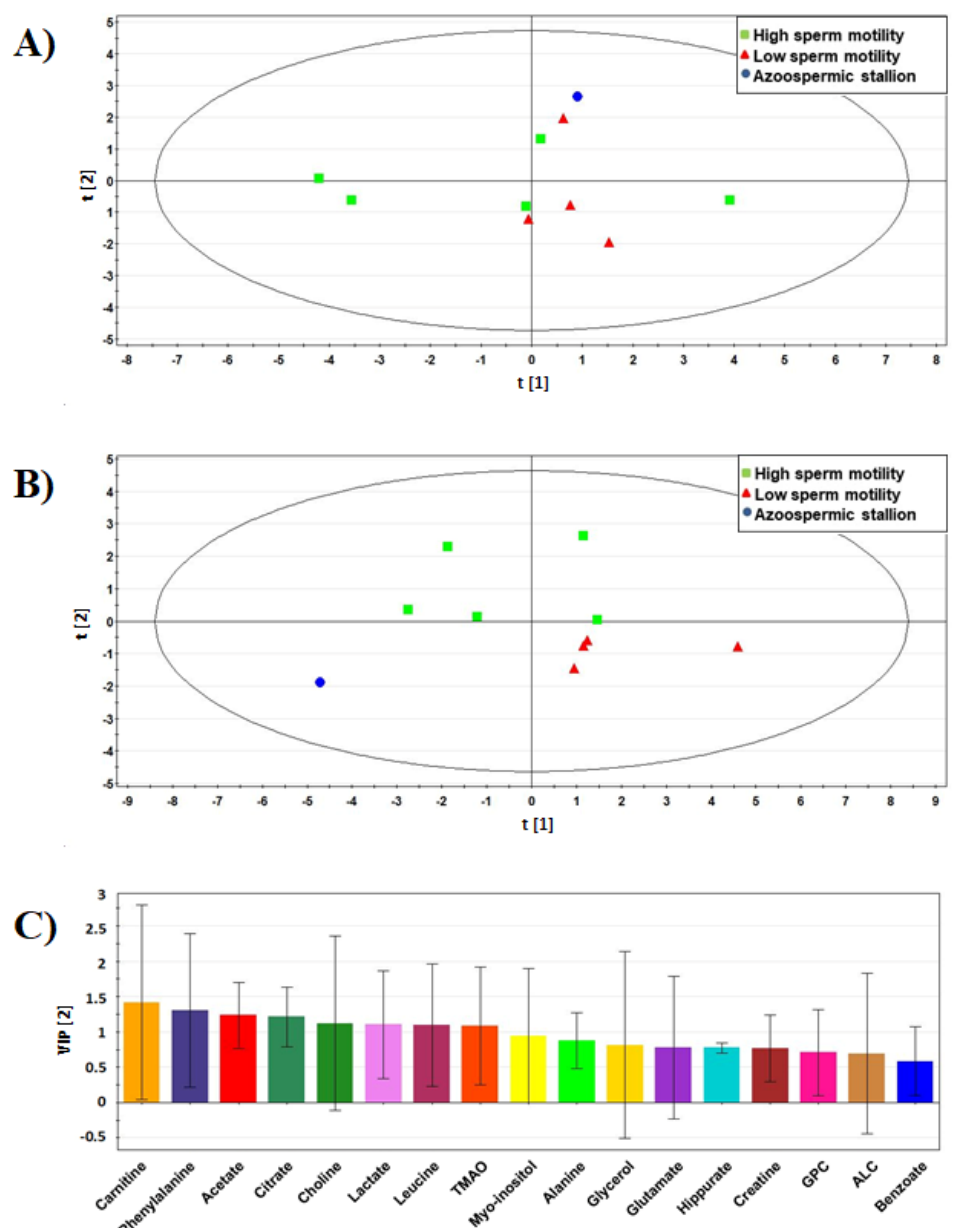
Figure 1. Multivariate analyses of seminal plasma metabolites of the 10 donkey stallions selected for the study and discriminated for sperm motility rate. ( A ) PCA score scatter plot from the 1 H-NMR spectral data. PCA resulted in a two-component model with an R 2 X of 0.822 and a Q 2 of 0.369. ( B ) PLS-DA score plot obtained from the same NMR data. The values of this two-component model were R 2 X = 0.567; R 2 Y = 0.652; Q 2 = 0.18. In both score plots, green boxes represent stallions with high sperm motility ( n = 5); red triangles represent stallions with lower sperm motility ( n = 4); a dot represent the azoospermic stallion ( n = 1). ( C ) Variable importance in projection (VIP) of the NMR variables for the model reported in B.